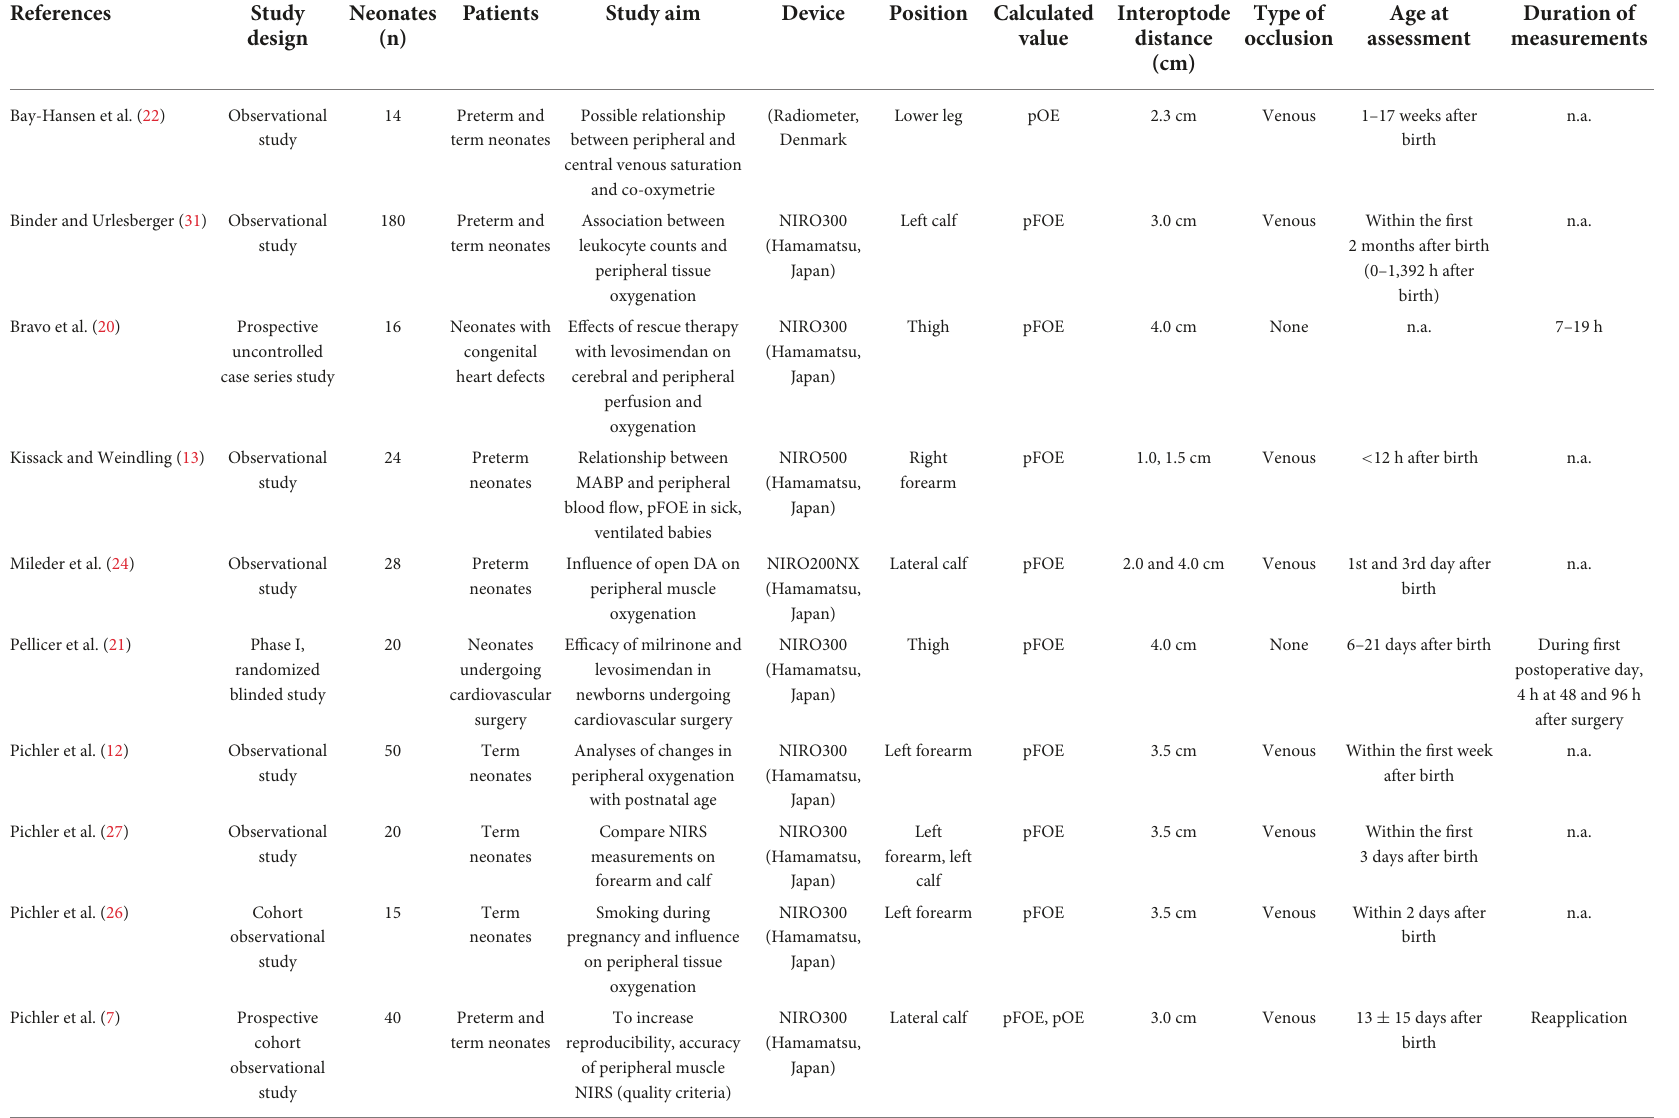
TABLE 1 Characteristics of the included studies in preterm and term neonates, listed alphabetically according to the last name of the first